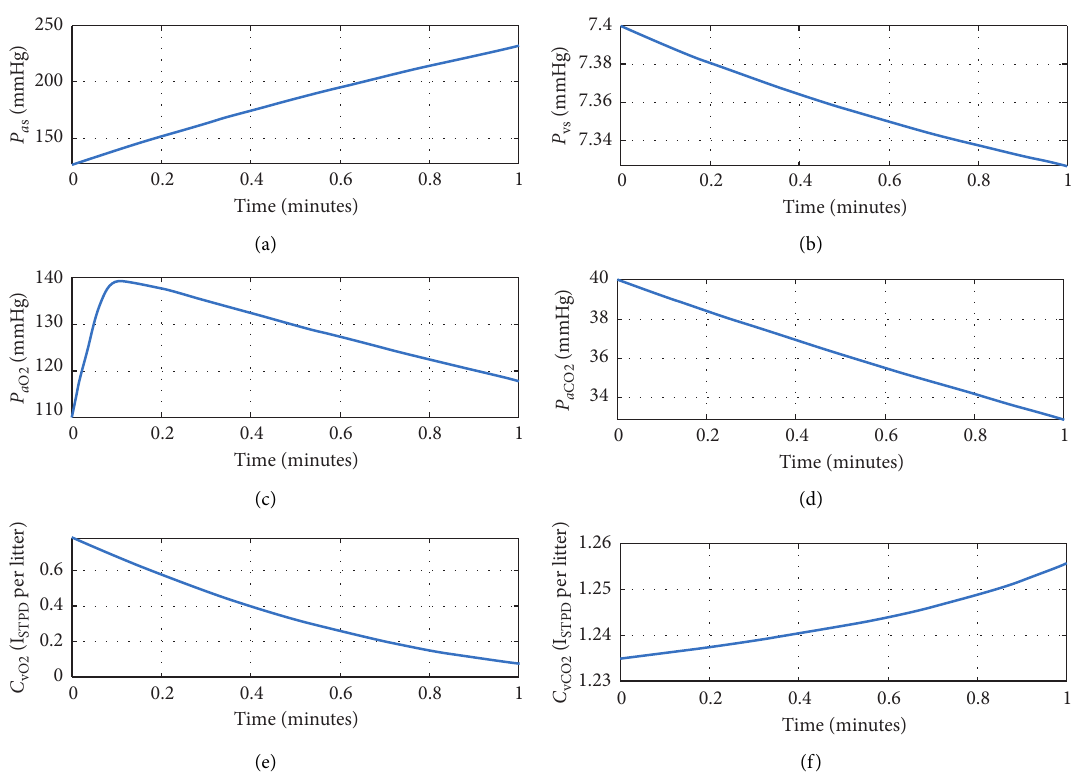
Figure 12: ICRSMM numerical test for an abnormal